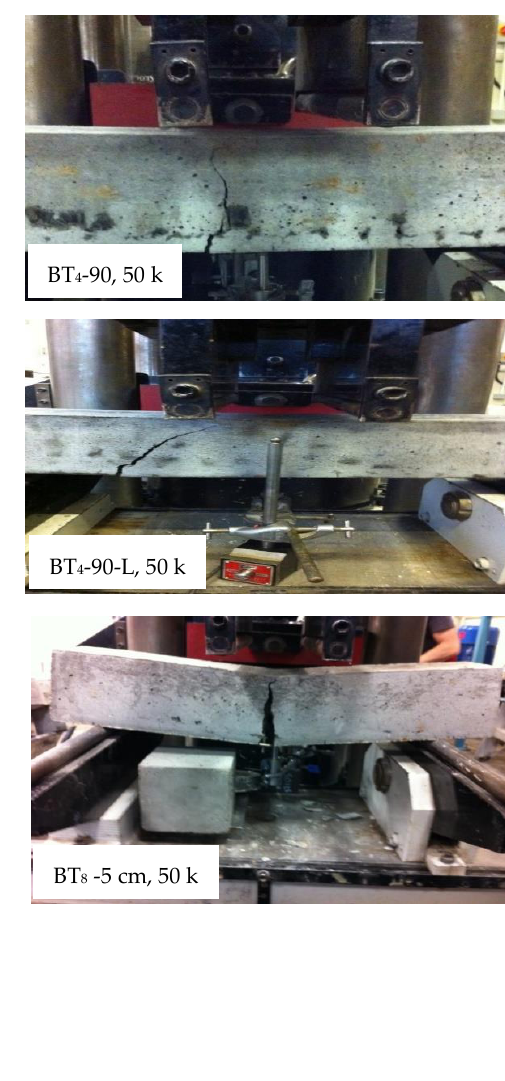
Figure 13. Mid-span load-deflection of TRC beams with web woven fabric (5 cm) at warp direction.